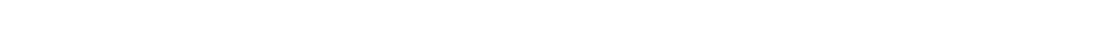
Frontiers in Materials | Colloidal Materials and